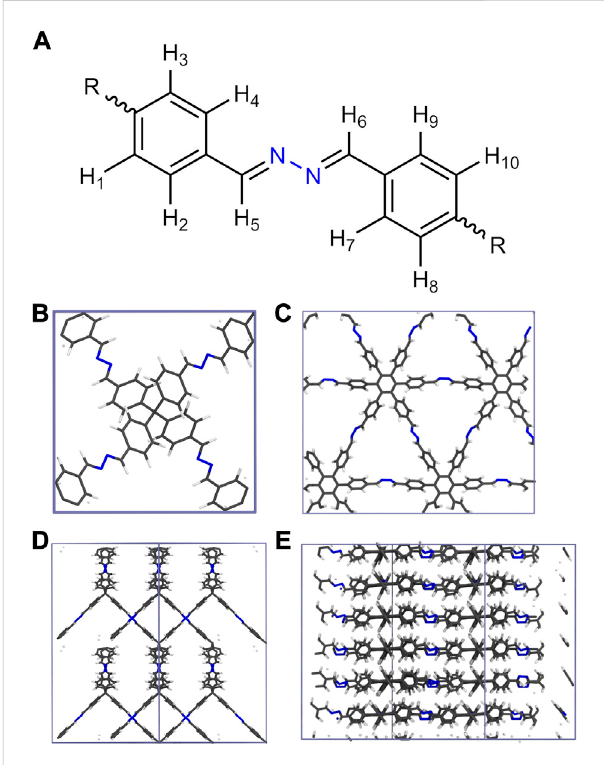
FIGURE 1 (A) Azine linking unit comprising both HEX-COF1 and 3D-HNU5 as well as the numbering scheme used to identify unique hydrogen atoms ( vide infra ), (B – E) Depiction of the unit cells of 3D-HNU5